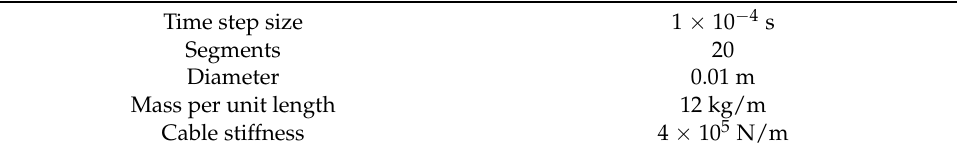
Figure 8. Initial setup of the floating-body experiment with mooring. Table 1. Moordyn setup.